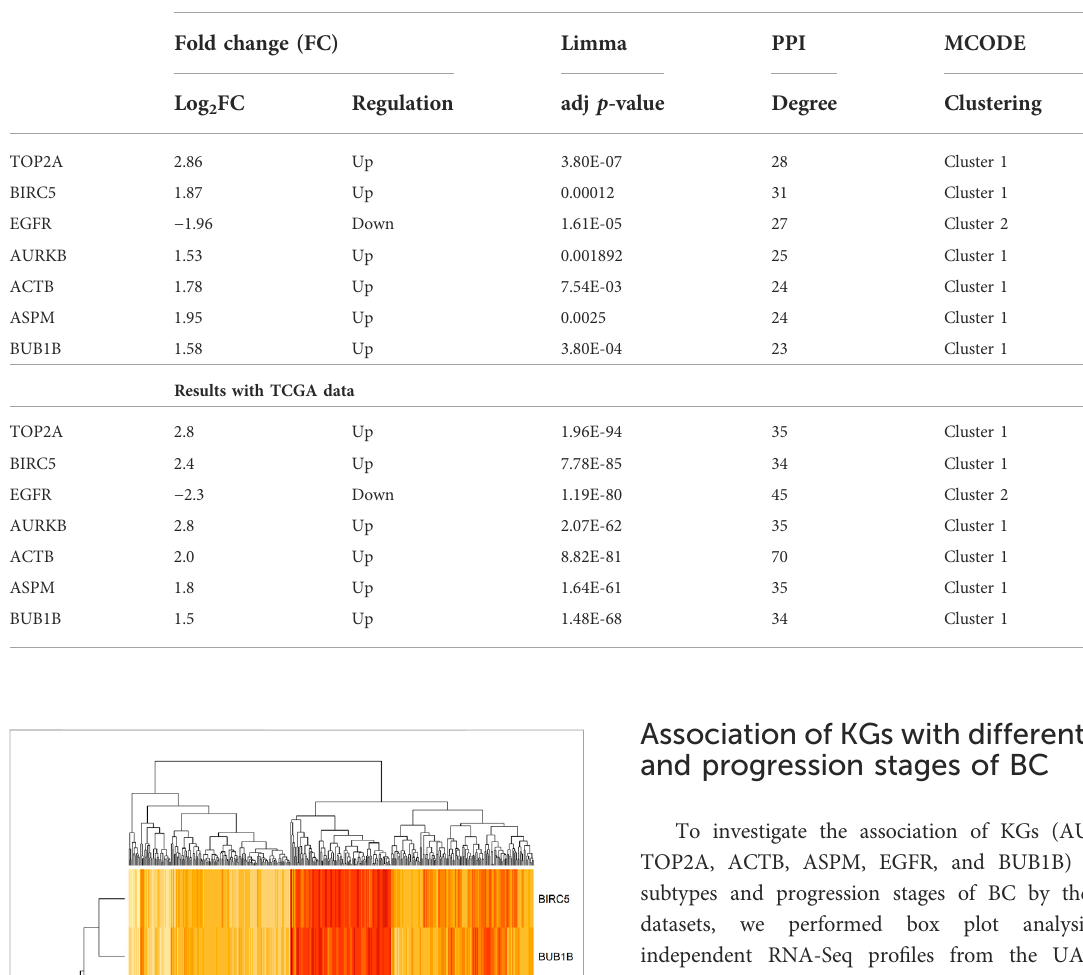
TABLE 2 Similarity and consistency of different computational results with KGs.